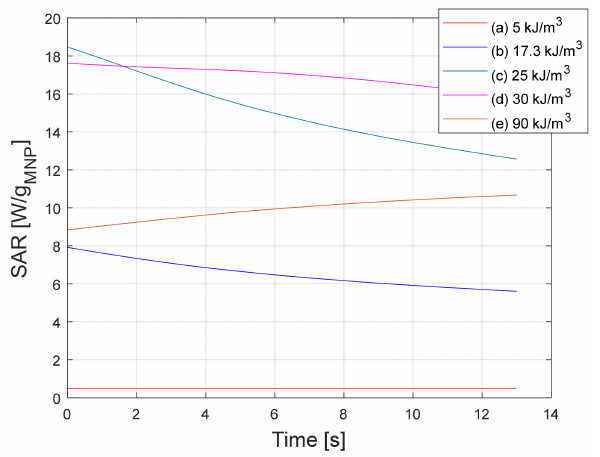
Figure 17. Comparison of time–SAR curves at different K eff . at magnetic field parameters being f = 281 kHz and H = 7.83